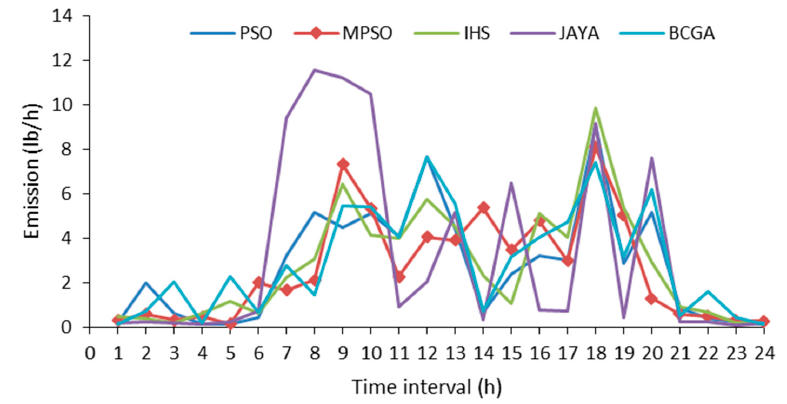
Figure 6. Emission curves obtained from MPSO, PSO, BCGA, IHS, and JAYA algorithms over the scheduling time.